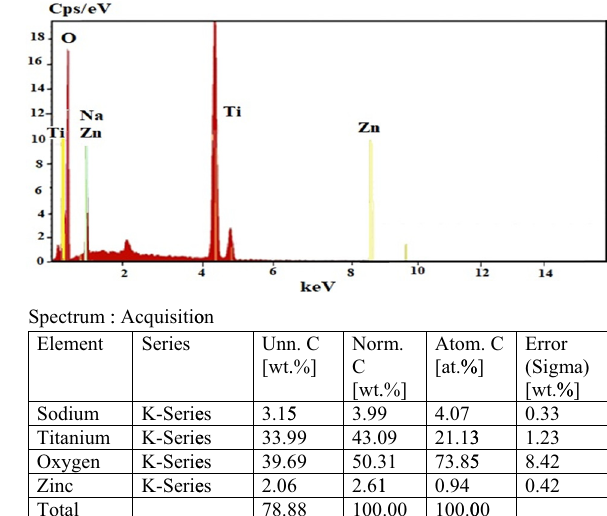
Figure 9: Surface materials identi fi cation of ZnO NSs –